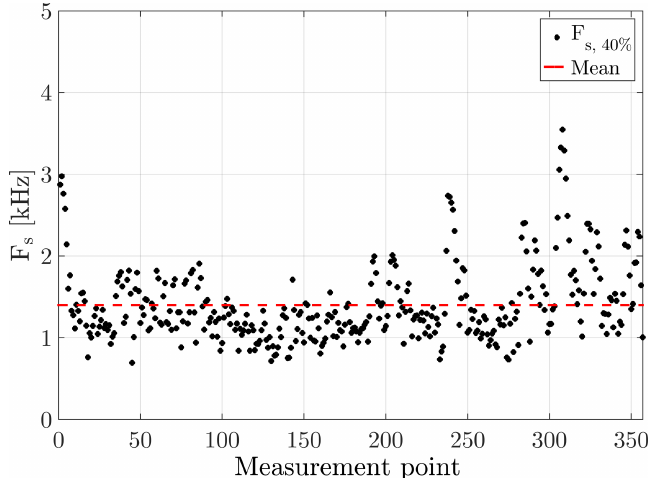
Figure A2. F S for all 357 time series of one wake; the mean value is indicated in red: (cid:104) F S (cid:105) = 1 . 4kHz.